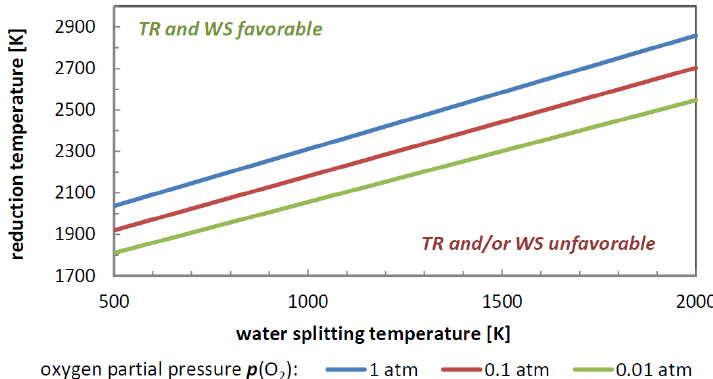
Figure 11. Thermal reduction temperature as a function of oxygen partial pressure [108].